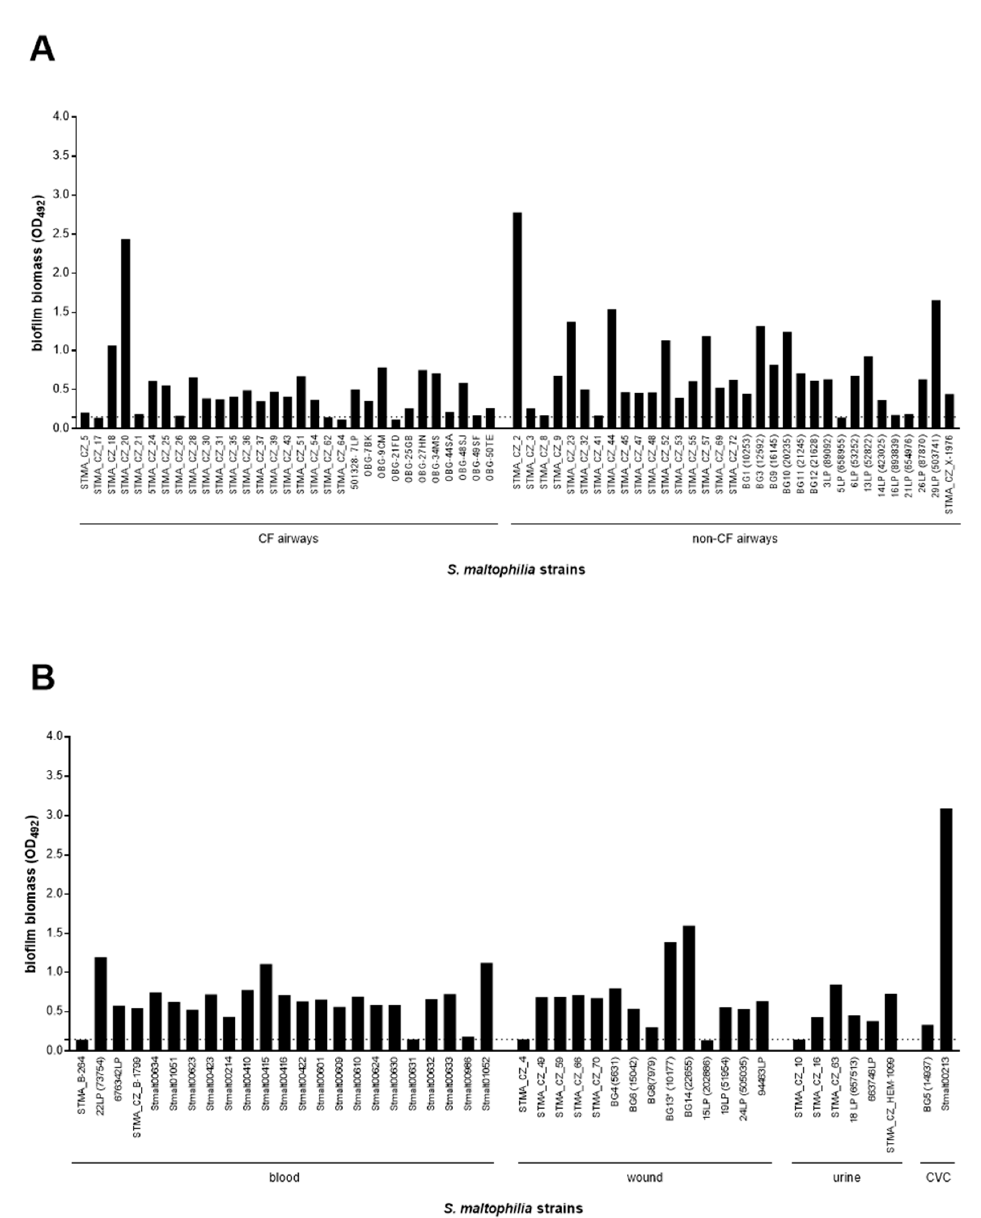
Figure 1. In vitro biofilm formation by 109 S. maltophilia strains grouped according to a clinical specimen type. The strains were collected from different sites at diagnostic laboratories of several countries (STMA: Czech Republic; BG: Serbia; Stmalt: Germany; LP: Spain; OBG: Italy): ( A ) airways, from patients with or without cystic fibrosis (CF); ( B ) blood, wound, urine, and central venous catheter (CVC). Biofilm biomass formation was evaluated using microtiter plate assay. Results are expressed as the mean optical density read at 492 nm (OD 492 ), with the horizontal dotted line indicating the OD cut-off value for biofilm formation (OD 492 : 0.150).